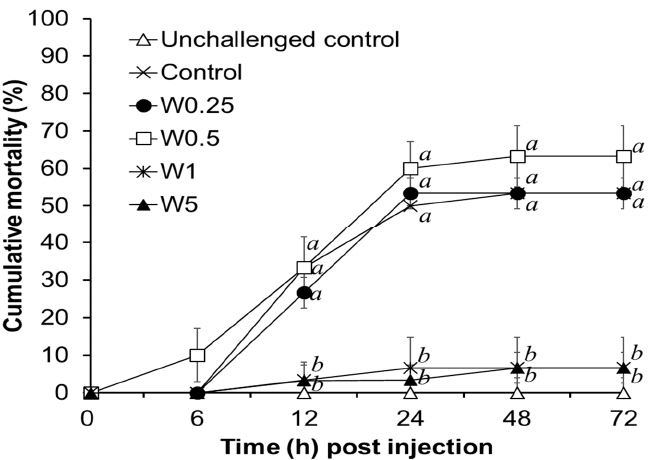
Figure 3. Cumulative mortality of shrimp reared in the water supplemented with different concen- trations of Micro-Aid Liquid 10 (MAL10) after being challenged with pathogen, Vibrio alginolyticus for 72 h. Data with different letters are significantly different among treatments ( p < 0.05) (Data of unchallenged control were not included for the statistical analysis). W0.25, W0.5, W1, and W5 were 0.25, 0.5, 1, and 5 mL m 3 − 1 of MAL10, respectively. n = 3.